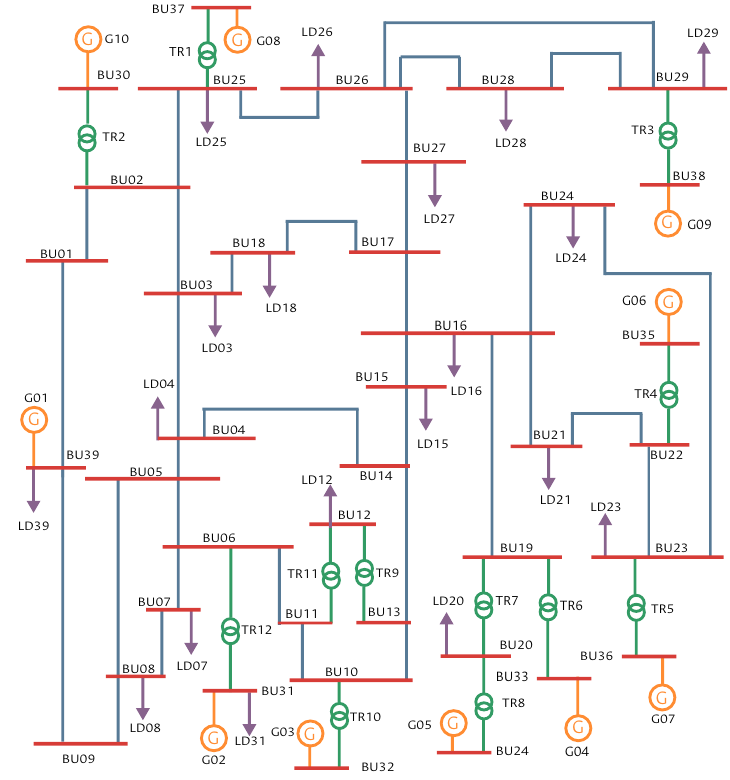
Figure 3. Transmission System of IEEE 39 New England Bus System